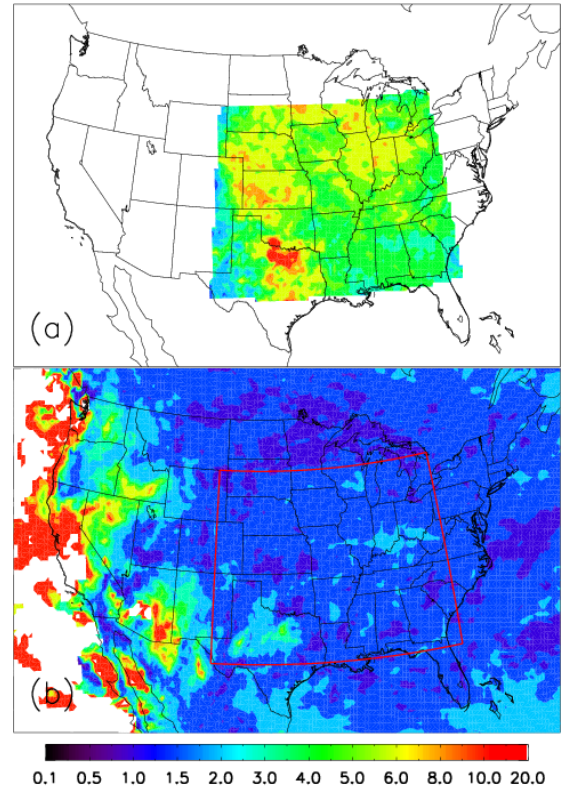
Fig. 8. IC:CG bulk ratios for JJA 2011 as (a) observed by ENTLN Fig. 8. IC : CG bulk ratios for JJA 2011 as (a) observed by ENTLN and (b) predicted by WRF at 36 km and (b) predicted by WRF at 36km grid spacing using PR93. The grid spacing using PR93. The ENTLN detection efficiency used here are 0.65 for IC and 0.95 for CG. ENTLN detection efficiency used here is 0.65 for IC and 0.95 for 36